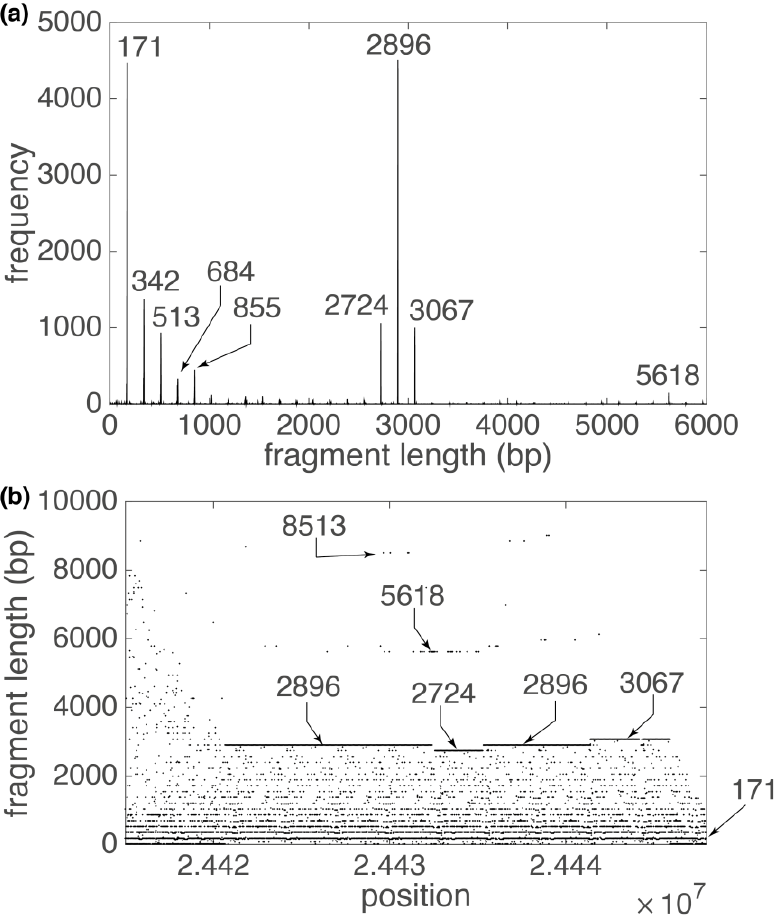
Figure 5. GRM diagram ( a ) and Fragment diagram ( b ) for alpha satellite 2896 bp HOR subarray in human chromosome 19 (Supplementary Table S1, repeat No. 1243). ( a ) Pronounced GRM peaks that correspond to alpha satellite HORs are denoted. The pronounced GRM peak at 2896 bp is a signature of 17 mer HOR (2896: 171 ≈ 17). ( b ) Each dot in the Fragment diagram corresponds to fragment length (component 𝑎 3𝑖 of vector 𝒂 𝑖 ) at that position (component 𝑎 1𝑖 of vector 𝒂 𝑖 ) . In the Fragment diagram, most points are located around y = n · 171 bp, which corresponds to multiples of alfa satellite lengths and peaks in GRM diagram. The highest concentration of points is at y = 2896 bp, which corresponds to 17 mer HOR length. There is also a smaller concentration of points at positions 5168 bp and 8513 bp, which are approximately multiples of 17 mer HOR length.